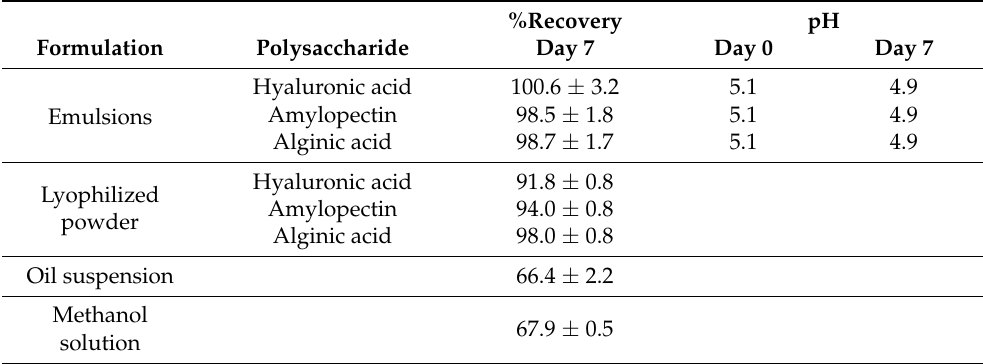
Table 4. Stability (%recovery) of griseofulvin and pH measurements of emulsions and lyophilized emulsions ± standard